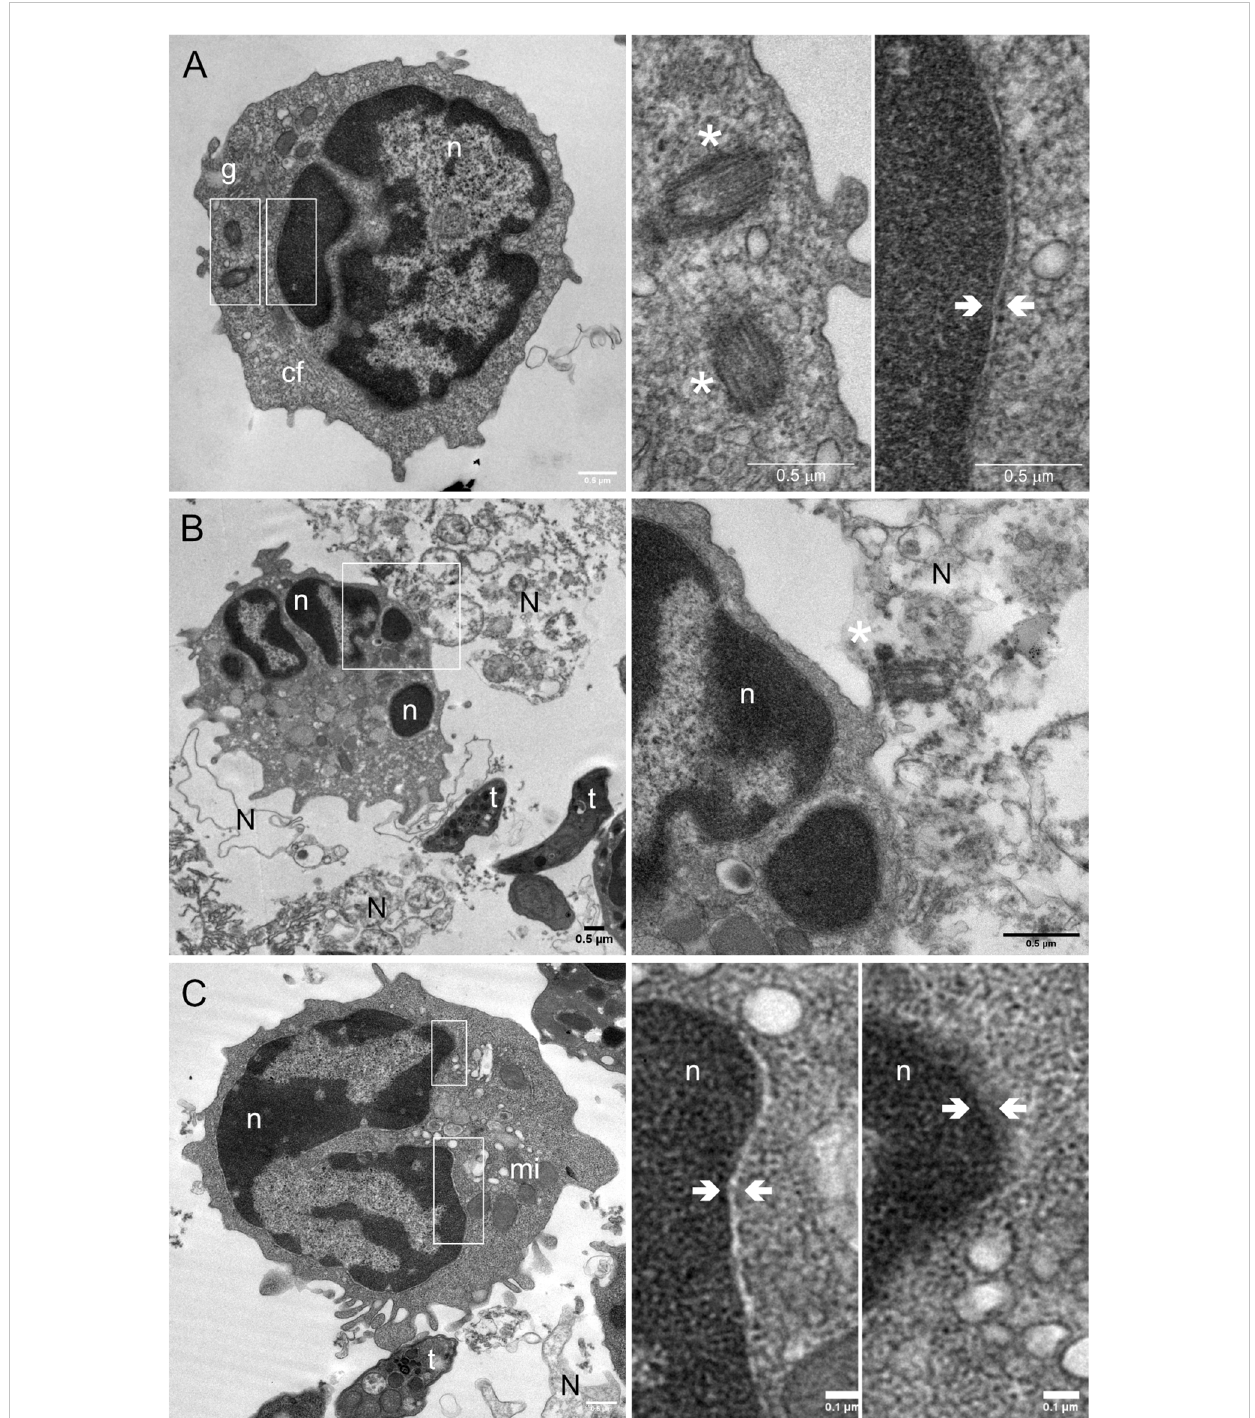
FIGURE 6 T. gondii tachyzoite-induced nuclear membrane disruption in exposed bovine PMN illustrated by transmission electron microscopy (TEM). 2 × 10 5 bovine PMN were confronted with vital 4 × 10 5 T. gondii tachyzoites (1:2 ratio) for 60 min. Samples were fi xed in glutaraldehyde 2.5% at 60 min of incubation and analysed by TEM. Non-stimulated PMN (= controls) (A) show typical ultrastructural details of PMN, such as a multilobulated nucleus (n), distinct subtypes of granules (g) and cytoskeletal fi laments (cf). White asterisks indicate the centrosomes, and the white arrows highlights the nuclear membrane. (B) After 60 min of exposure to T. gondii tachyzoites (t), bovine PMN released NETs (N) and centrosomes were observed associated with the DNA (*). NET formation was accompanied by disruption of the nuclear membrane (C) ; mi = mitochondria. White boxes indicate the regions of the image that are zoomed out in the corresponding right